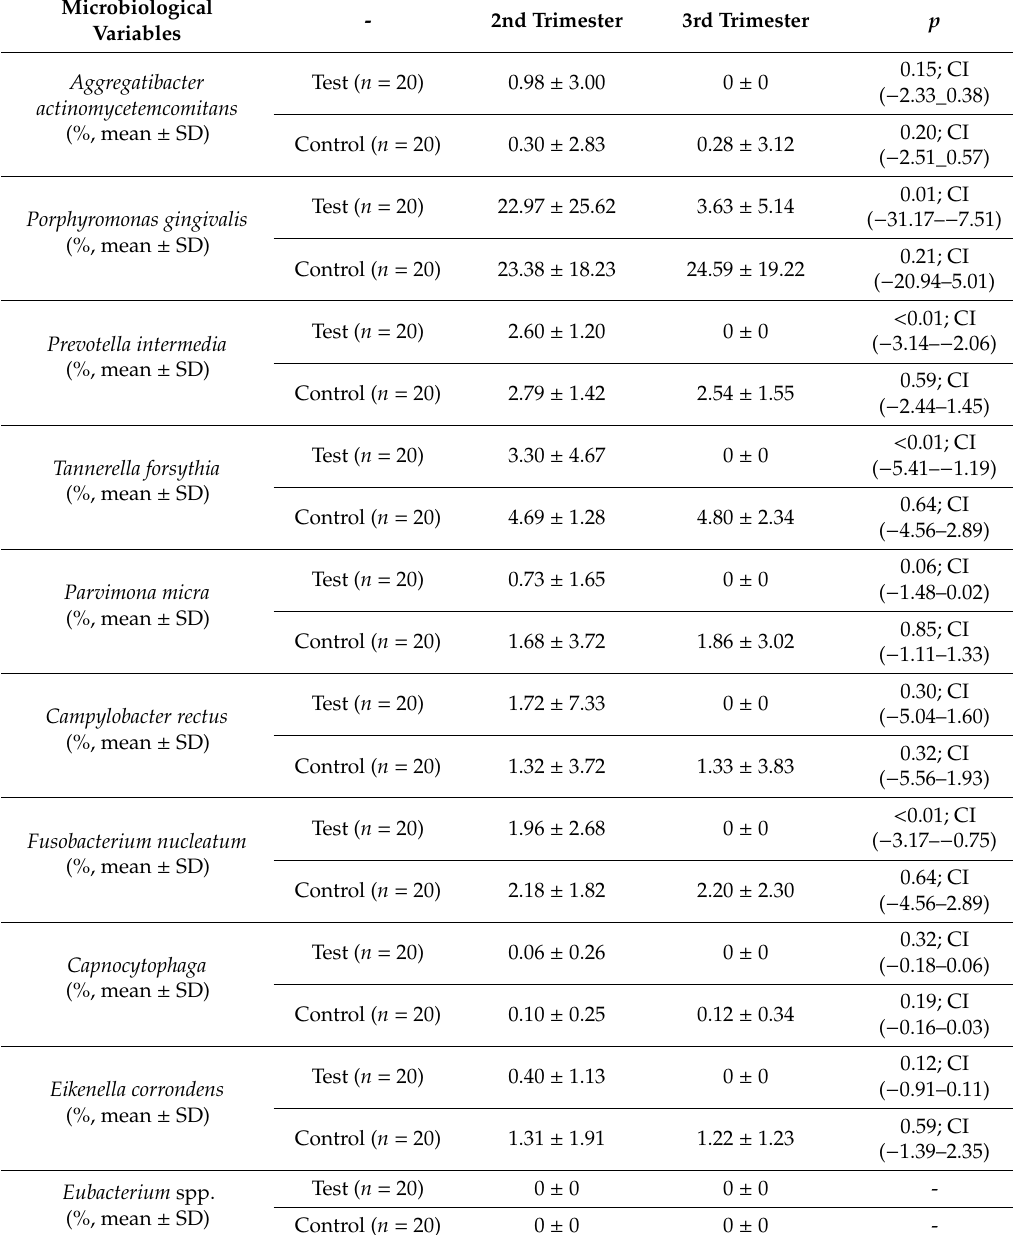
Table 4. Proportions of di ff erent bacterial species in test and control groups in 2nd and 3rd trimester.